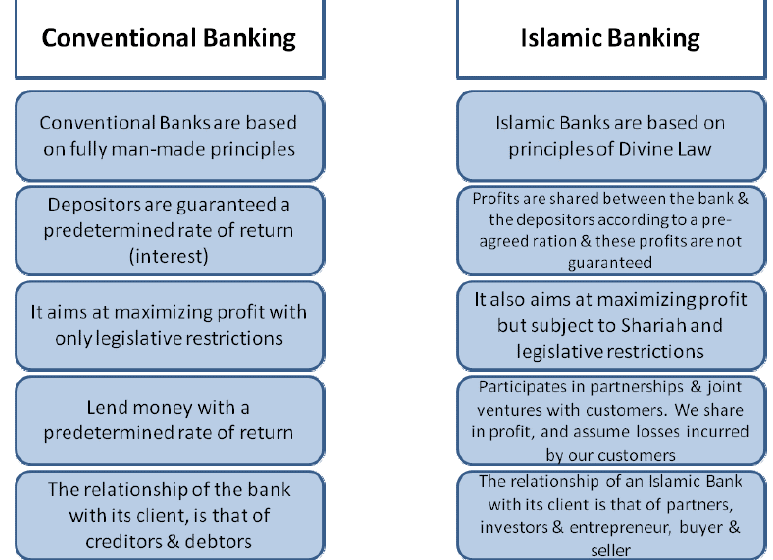
Fig. 1. Key differences between Islamic and conventional banking Source: Adapted from Suliman